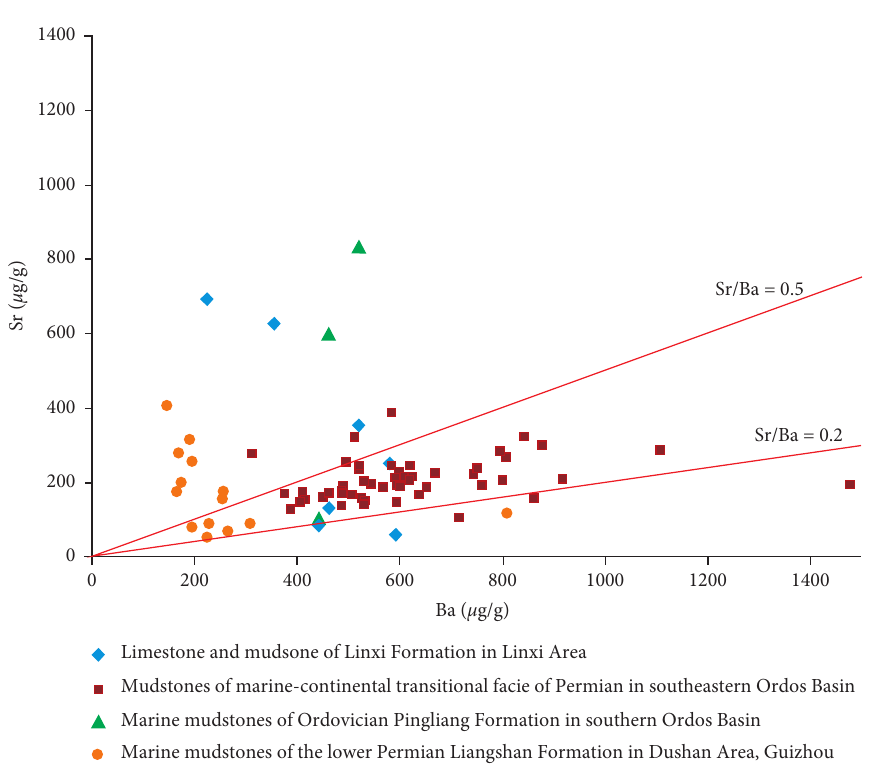
Figure 6: Relationship between the Sr and Ba contents of the Linxi Formation limestone from the Linxi area Guandi profile in eastern Inner Mongolia and comparison with other regions in